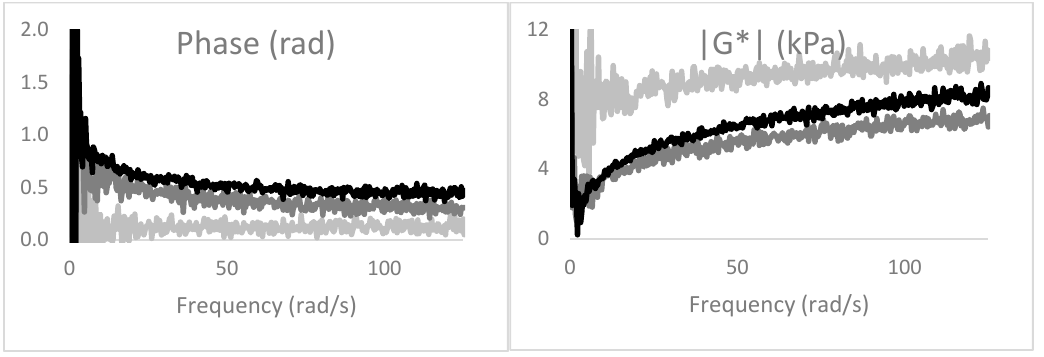
Figure 12. Frequency response for ethyl vinyl acetate (EVA) at 97 °C (experimental), and the modelled impedance Due to ambiguity of the results at 72 ° C, experimental results at 64 °C, 72 °C and 79 °C are